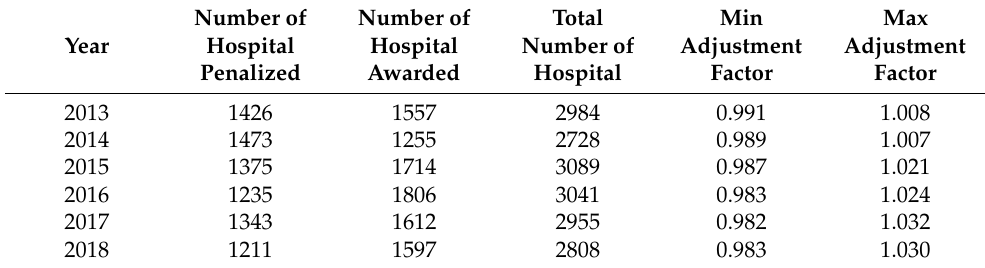
Table 1. Number of hospitals awarded and